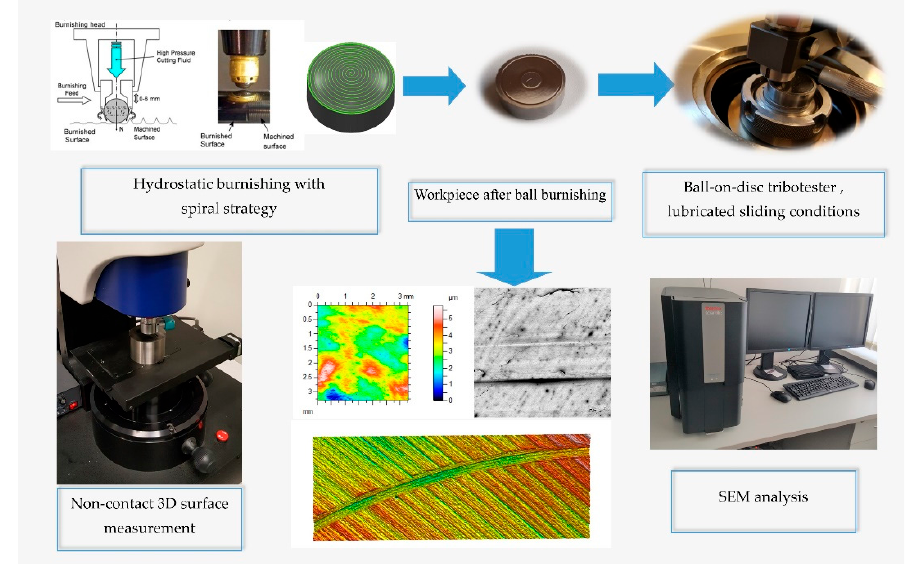
Figure 1. Scheme of experiments.